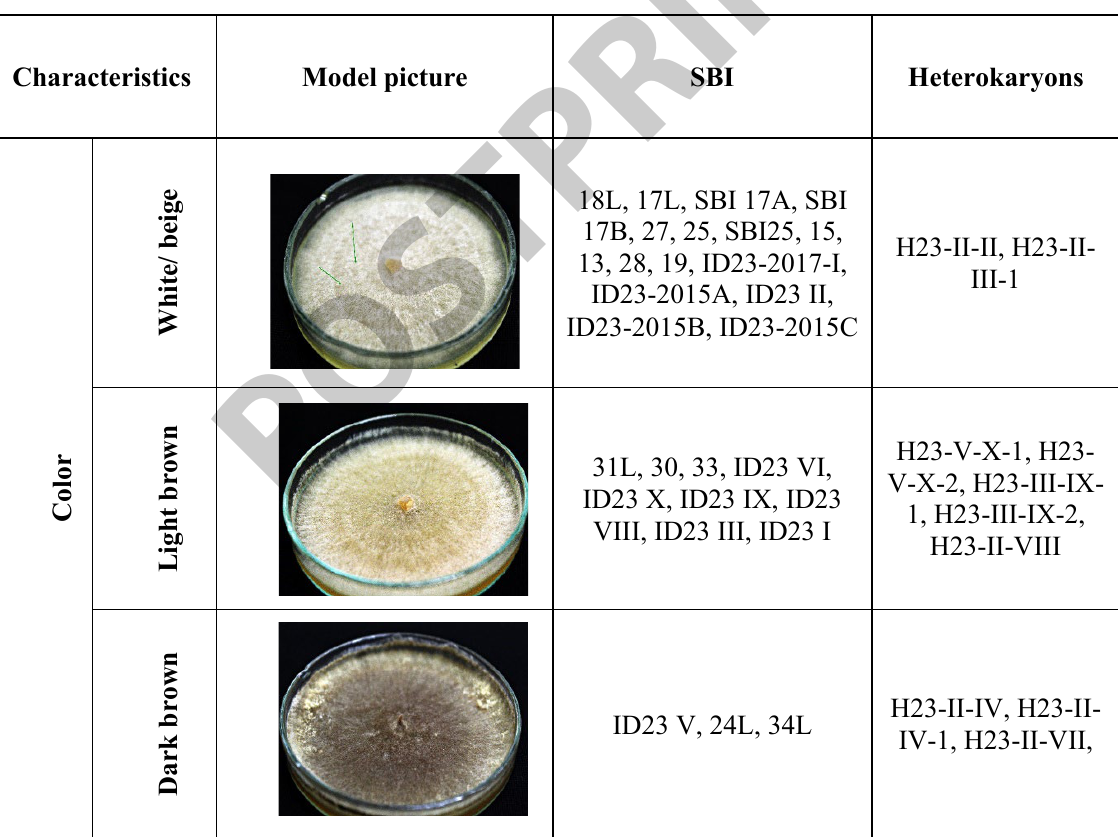
Table 2. Morphological characteristics of R. solani AG5 isolates